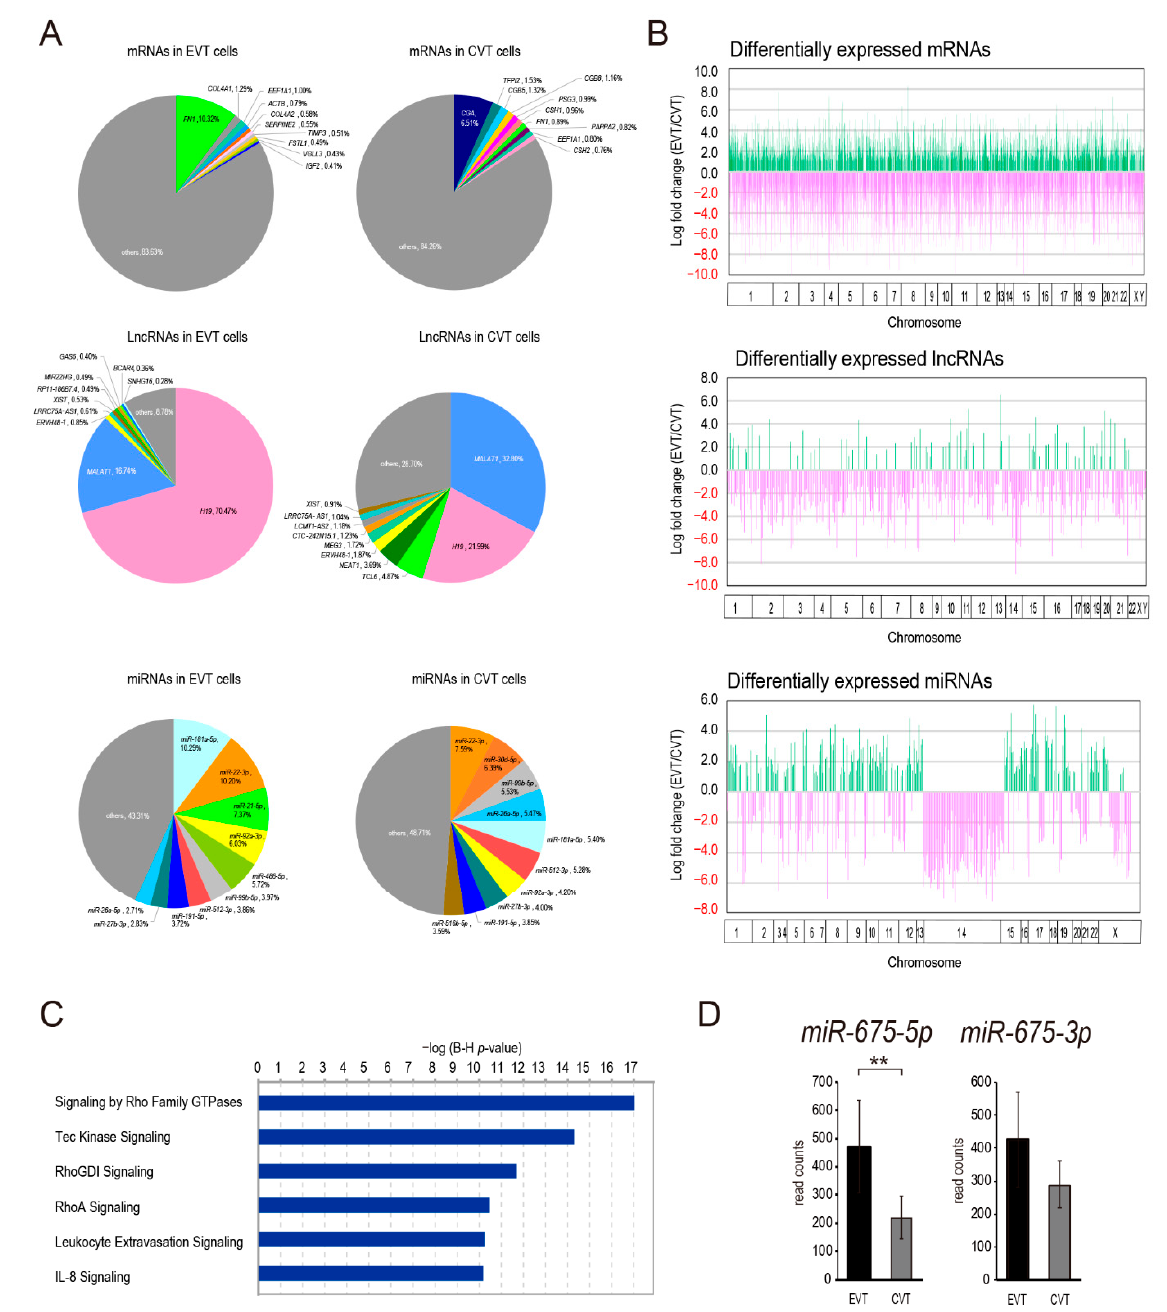
Figure 1. RNA-sequencing analysis of extravillous trophoblast (EVT) cells isolated from first-trimester human placentae. ( A ) Pie charts showing the top 10 most abundant genes (mRNAs, lncRNAs, and miRNAs) in EVT and chorionic villous trophoblast (CVT) cells, expressed as percentages. ( B ) The chromosomal distribution and expression of DEGs (mRNAs, lncRNAs, and miRNAs) across human chromosomes in EVT cells. The y -axis represents log2 fold change in gene expression. The x -axis represents chromosome number (1–22, X, and Y). The cell size of each chromosome is shown by the total number of DEGs contained in each chromosome. In each chromosome, DEGs are ordered along the x -axis according to their genomic position (left to right). ( C ) IPA canonical pathway analysis of EVT-associated DEGs. The most relevant canonical signaling pathways for DEGs are shown; the x -axis represents the − log of the p -value calculated using the Benjamini–Hochberg method. ( D ) RNA-sequencing analysis of miR-675-5p and miR-675-3p in EVT and CVT cells. The y -axis represents the mean of normalized counts. Data are presented as the mean ± standard deviation (SD) of the analysis of three independent samples; ** q <